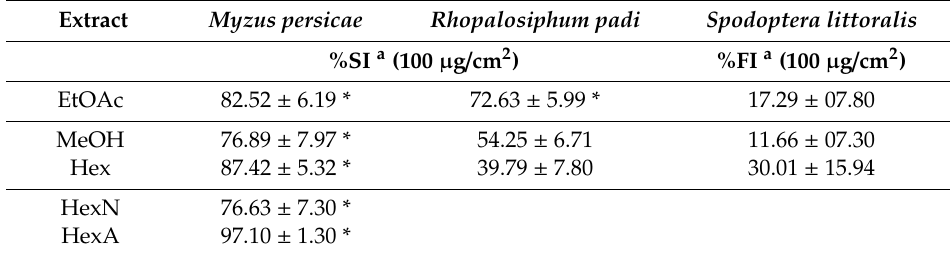
Table 2. Insect antifeedant e ff ects of Trichoderma sp. EFI 671 extracts (EtOAc), solvent partitions of the EtOAc extract (MeOH, Hex) and acid partition of the Hex extract (HexN, HexA) $ against